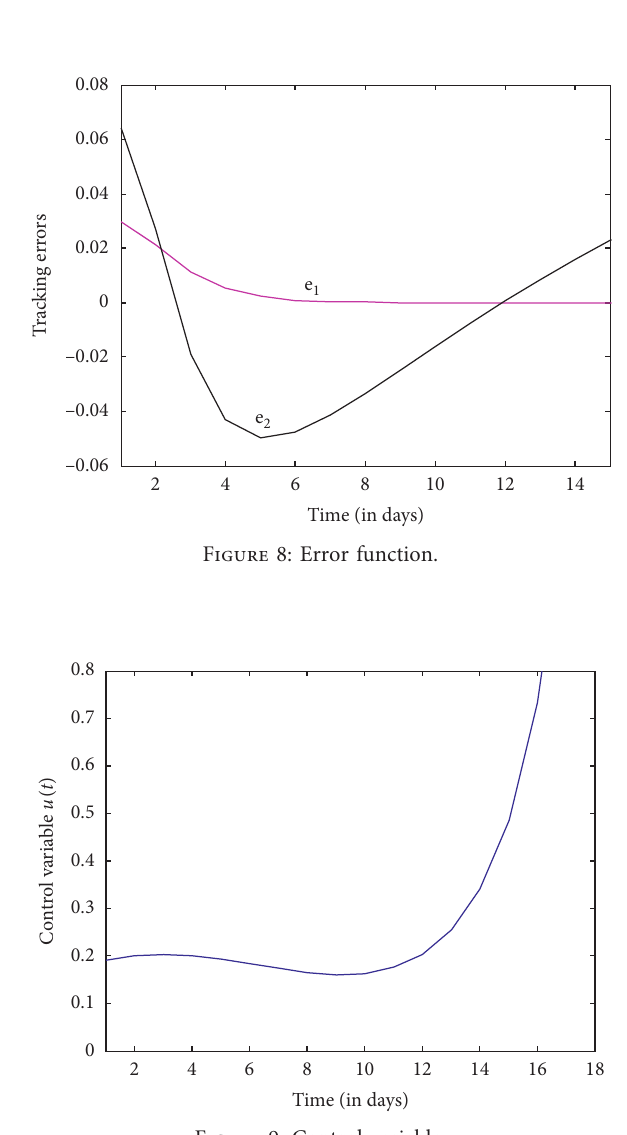
Figure 9: Control